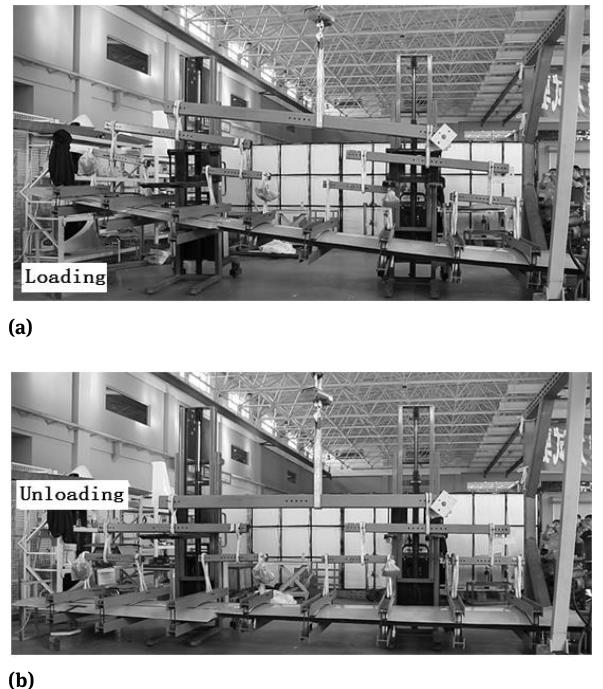
Figure 6: The result of static